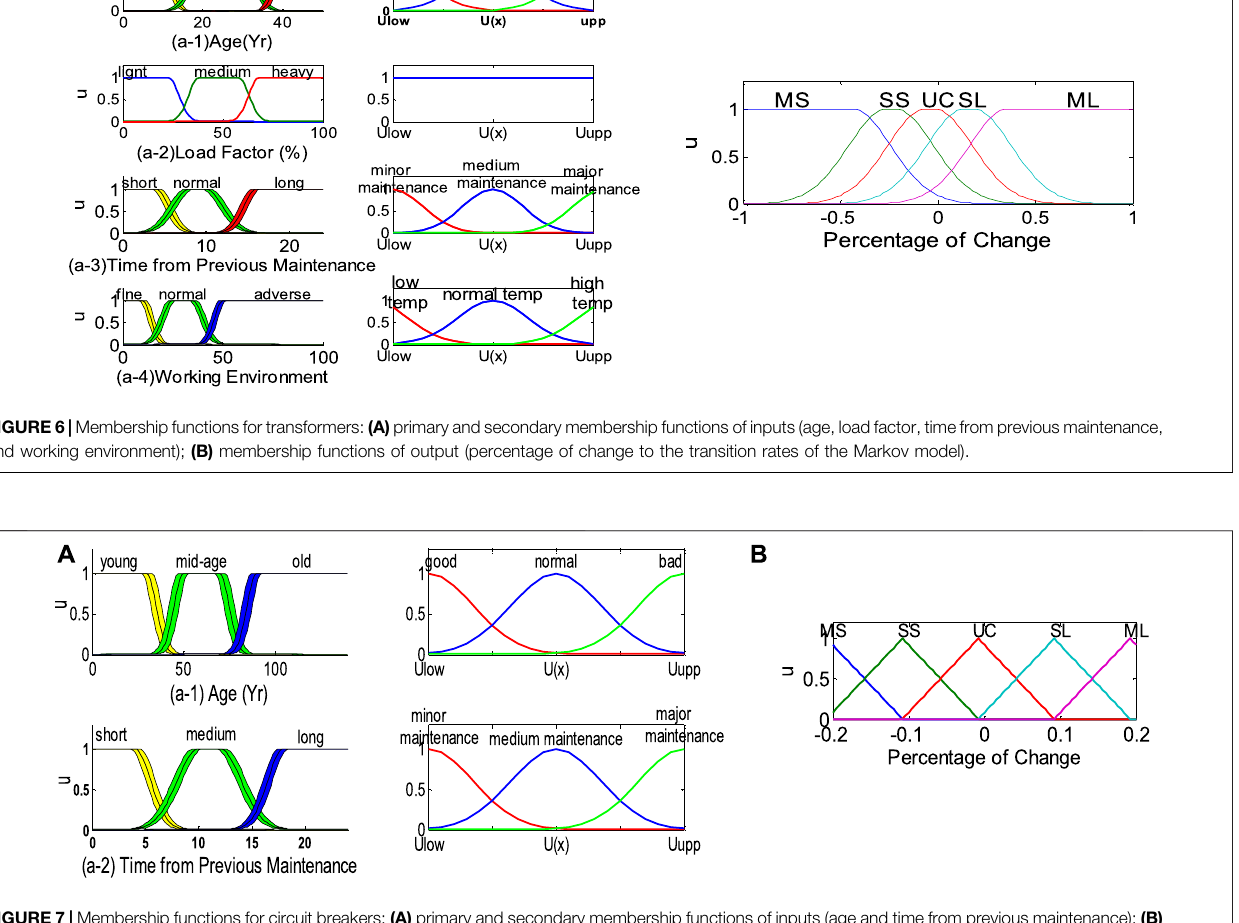
FIGURE 7 | Membership functions for circuit breakers: (A) primary and secondary membership functions of inputs (age and time from previous maintenance); (B) membership functions of output (percentage of change to the transition rates of the Markov model).